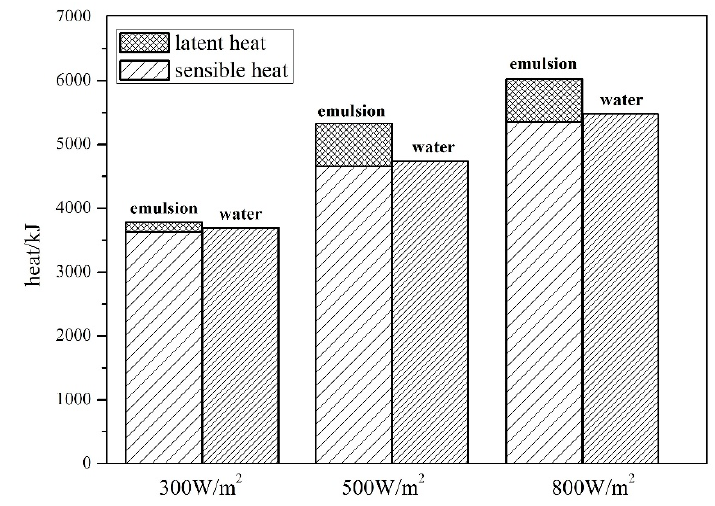
Figure 14. Heat storage under different radiations.